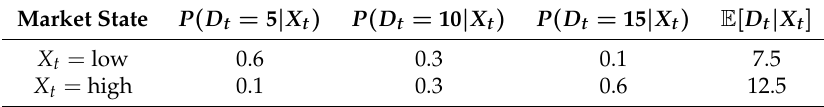
Table 1. Conditional probability mass function for the